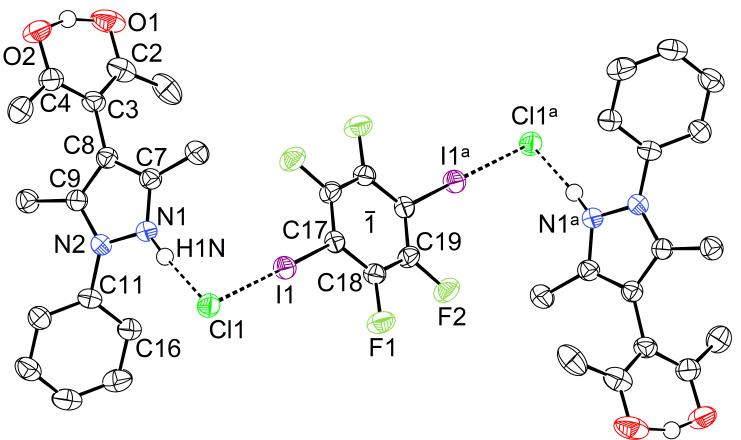
Figure 6. Displacement ellipsoid plot [30] of 2 (80% probability, C bonded hydrogens omitted). Selected intramolecular distances and angles (Å, °): I1 ··· Cl1 3.1653(11), Cl1 ··· N1 2.970(2), I1 ··· Cl1 ··· N1 73.99(4), C17–I1 ··· Cl1 179.32(6), Cl1 ··· H1N–N1 172(3). Symmetry operation: a = 1 − x , − y ,1 − z